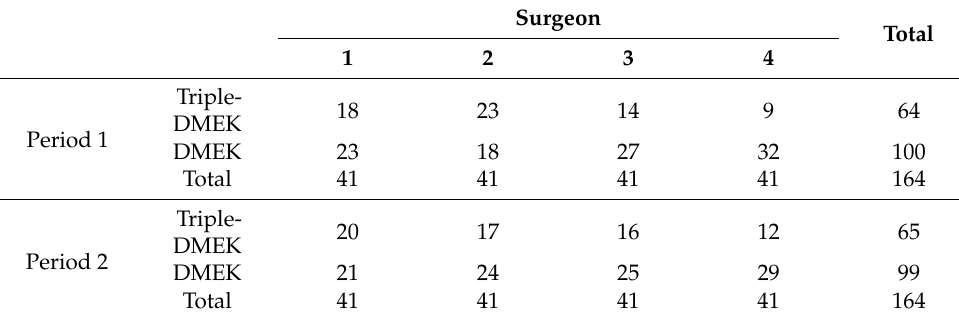
Table 1. Individual numbers of surgeries for 4 surgeons in period 1 and period 2 [Period 1 = first 41 surgeries of each surgeon; Period 2 = last 41 surgeries of each